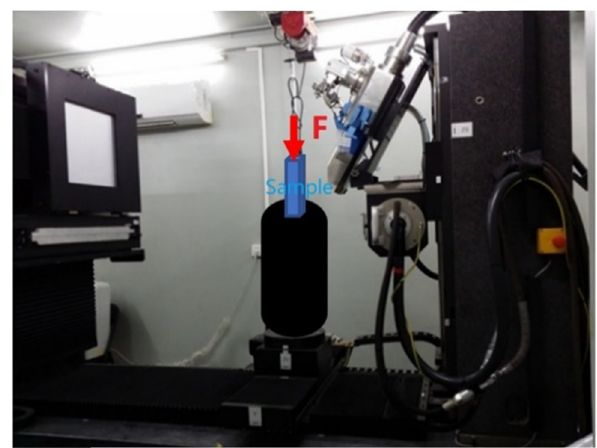
Figure 2: Structure of plain